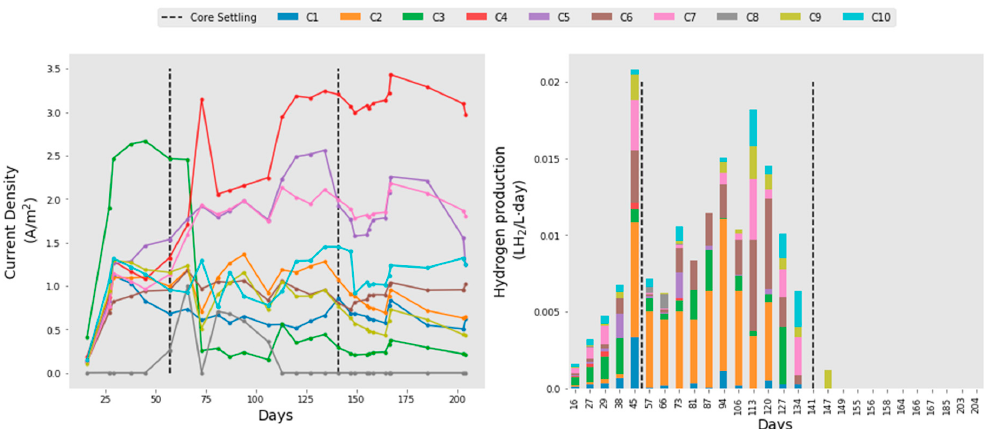
Figure 5. Current density (left) and hydrogen production (right) during start-up, batch mode and continuous flow in each individual electrode. Continuous flow started on day 39. continuous flow in each individual electrode. Continuous flow started on day